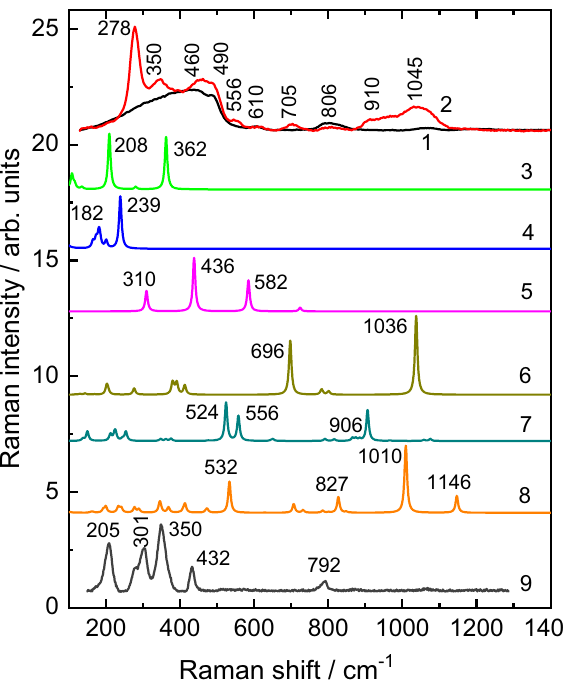
Figure 8. Experimental Raman spectra of rubidium cell measured in the regions of clean SiO 2 glass (1) and contaminated black spot (2) together with the simulated Raman spectra of Rb 4 Si 4 (3), Rb 2 O 9 (4), SiO 4